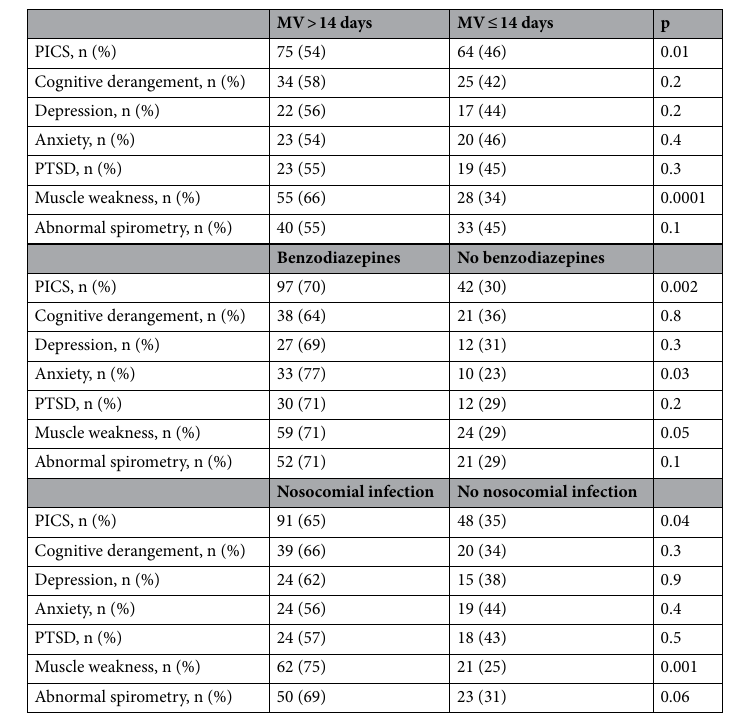
Table 6. Association of the variables related to PICS with psychiatric, cognitive and physical domains (N = 186). PICS post-intensive care syndrome, MV mechanical ventilation, PTSD post-traumatic stress